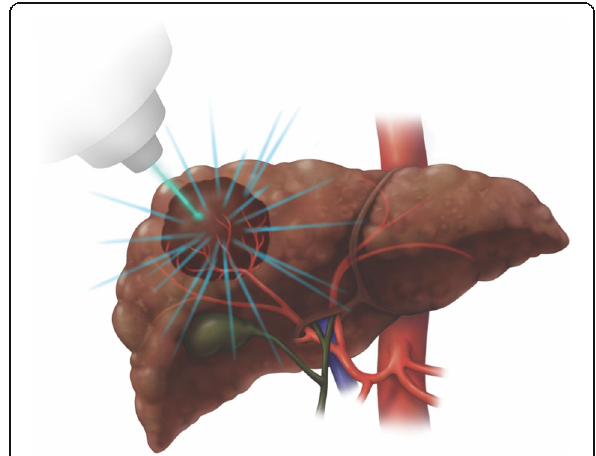
Fig. 27 Stereotactic body radiotherapy (SBRT). The tumor is targeted by static conformal beams matching tumor shape and limiting radiation dose to adjacent organs and non-target liver